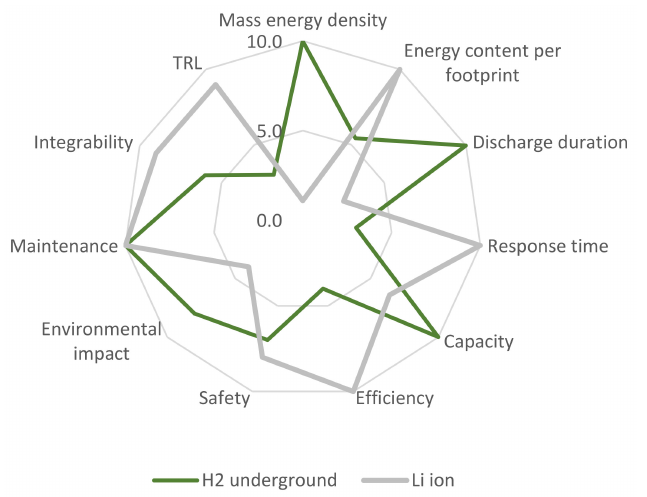
Figure 13. Spider chart of a hybrid battery–hydrogen system performance for each KPI. The data are available in Table